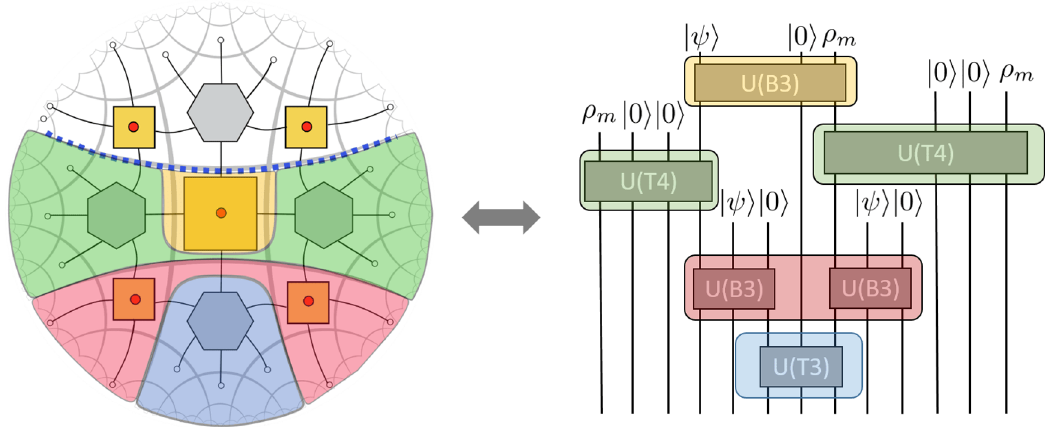
Figure 31. We can choose to decode the blue and red regions before the green region, whereas the previous construction corresponds to decoding the green and blue regions